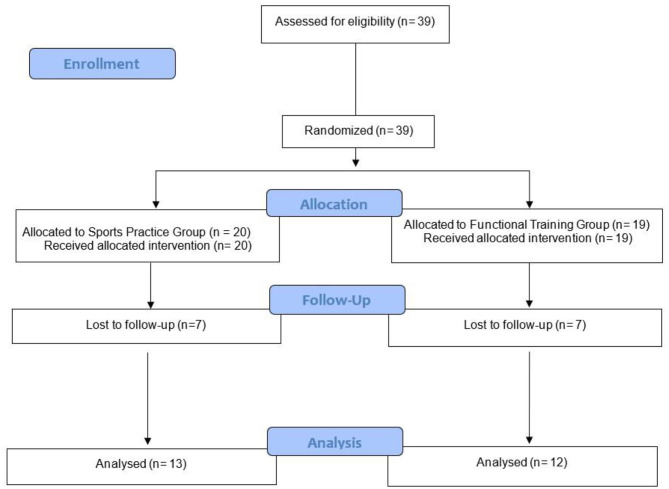
Flowchart of the present study.